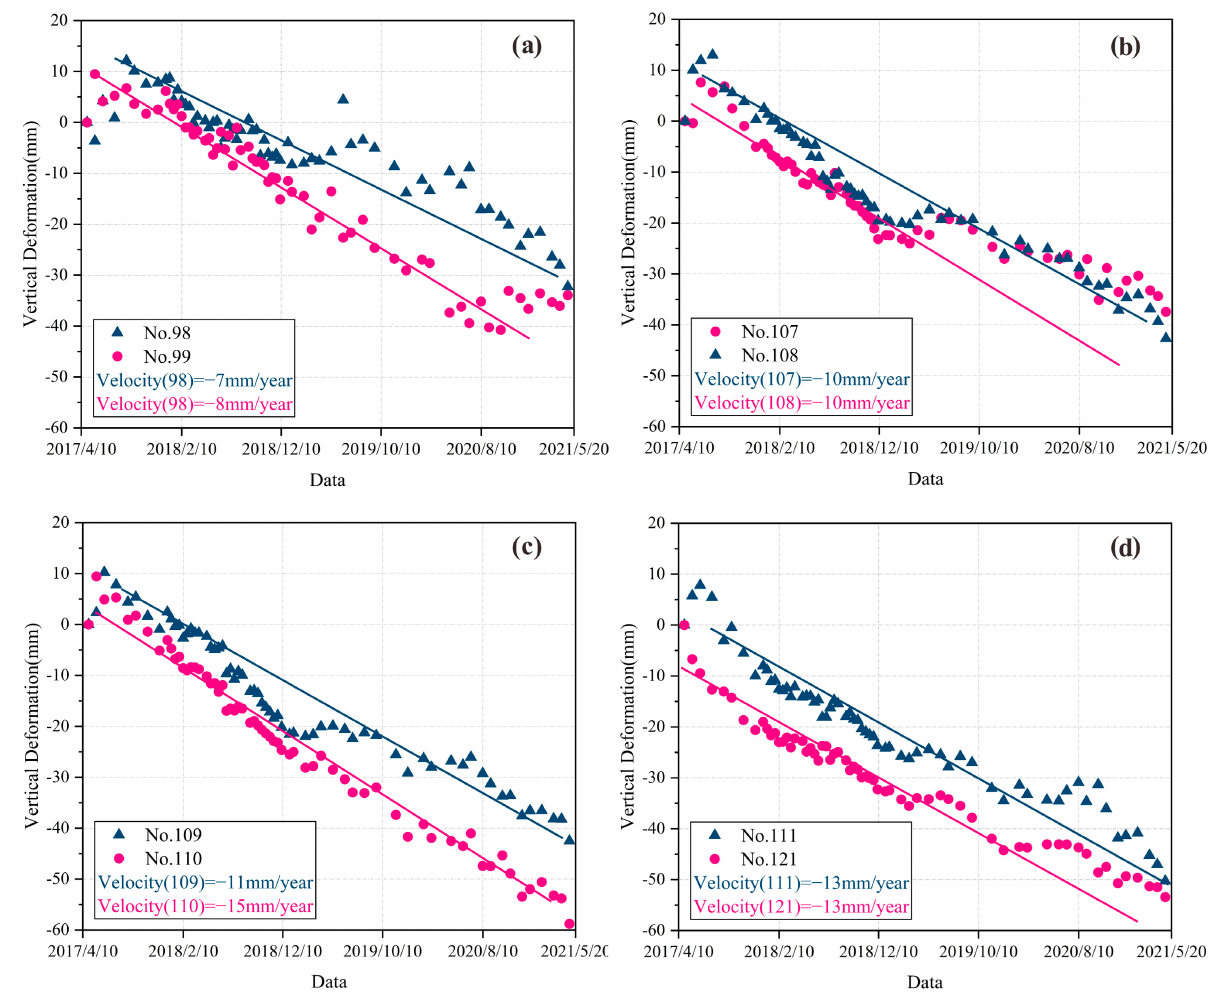
Figure 7. ( a ) Vertical deformation time-series at No. 98–99, ( b ) No. 107–108, ( c ) No. 109–110, and ( d ) No.